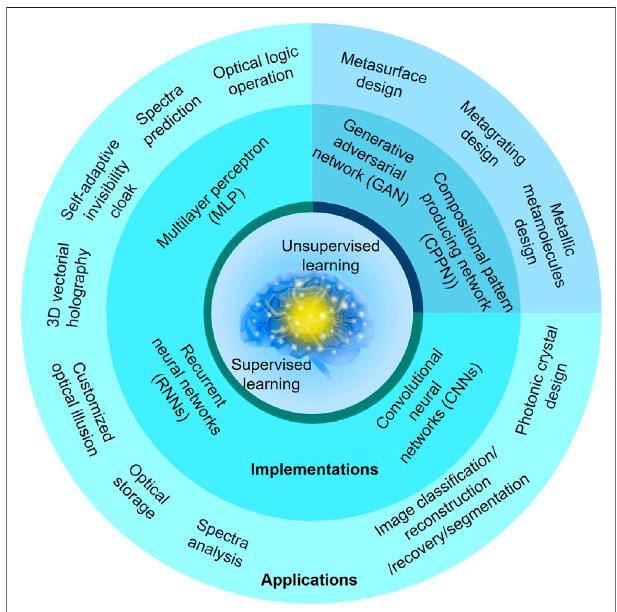
FIGURE 1 | Applications of the deep learning in optical structure design and data